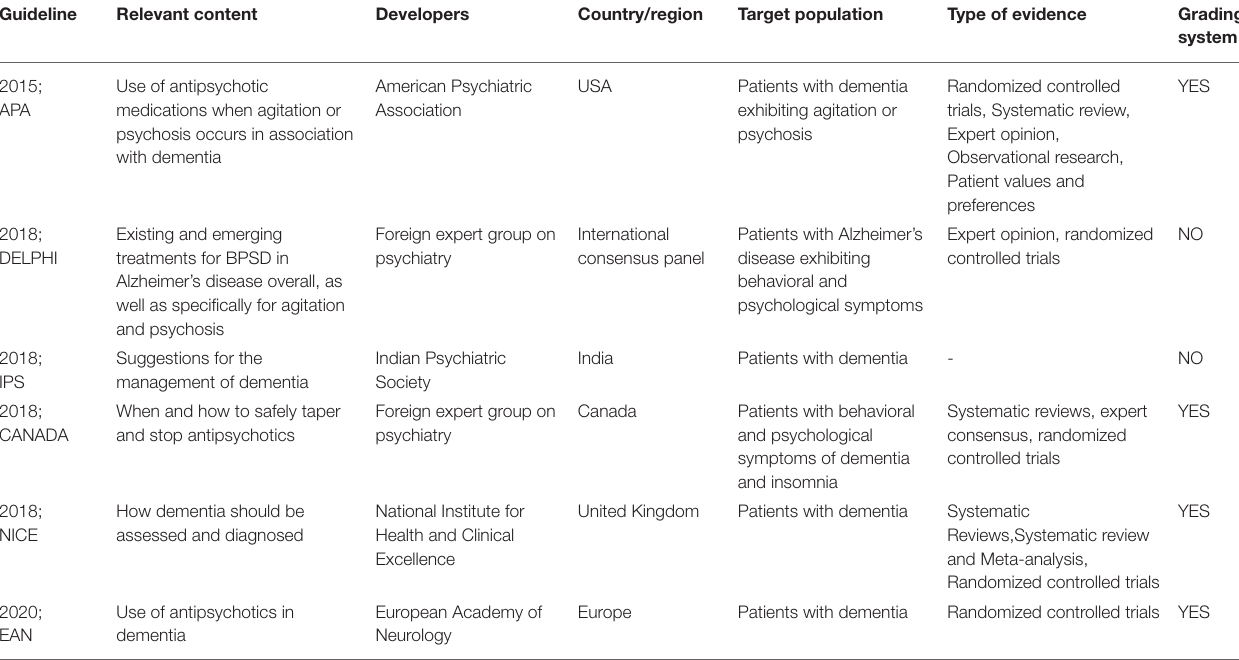
TABLE 1 | Clinical practice guideline characteristics and development methods for recommendations.